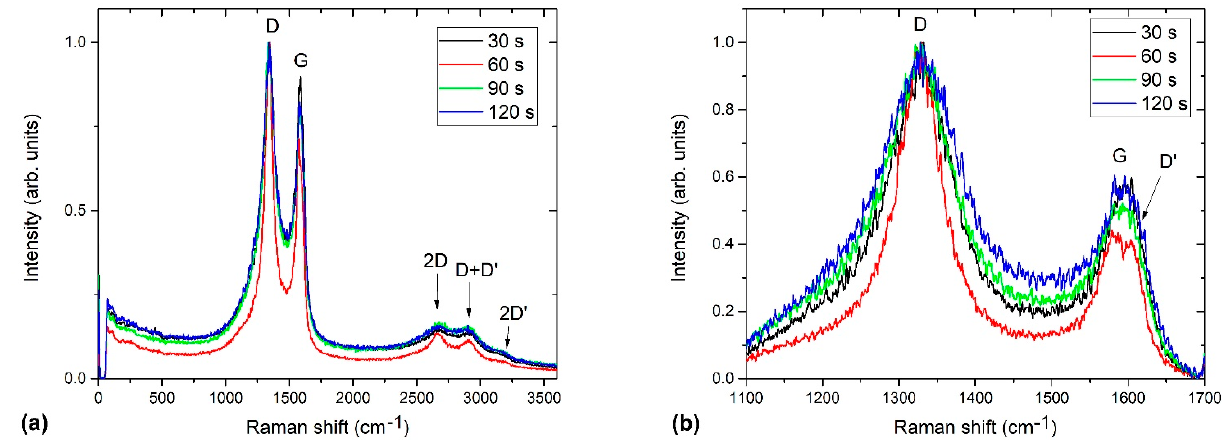
Figure 12. 2D SIMS image of N-doped carbon nanomesh surface: ( a ) distribution of carbon fragments, and ( b ) distribution of nitrogen-containing fragments. The deposition time was 60 s.